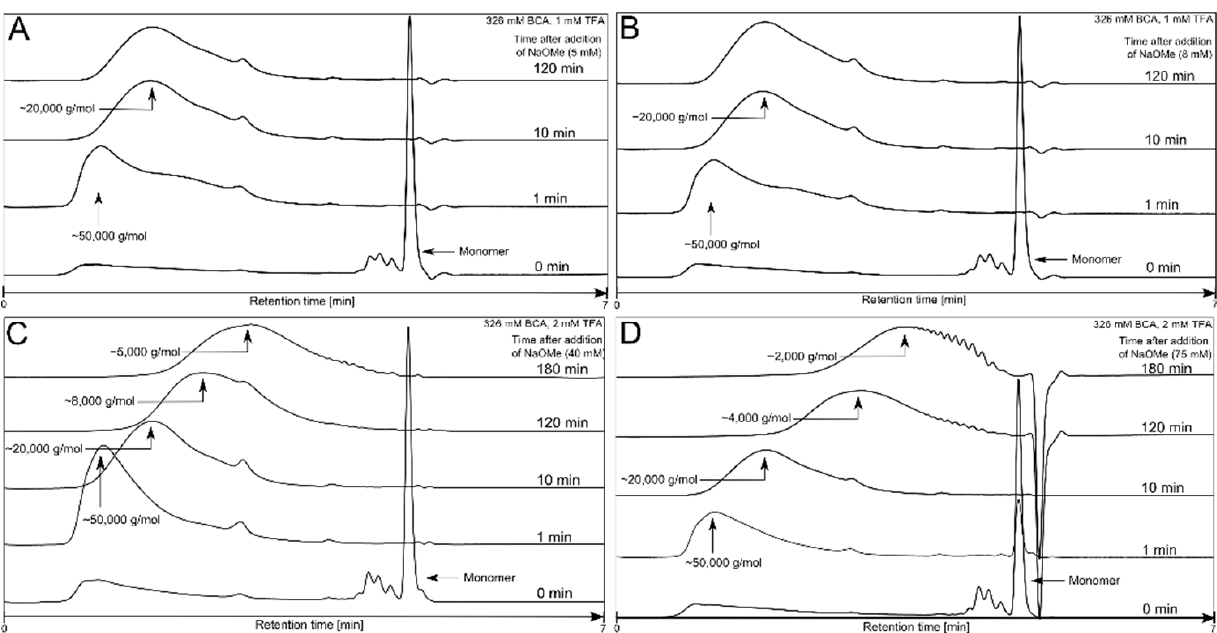
Figure 3. Initiation, propagation and depolymerization–repolymerization steps involved during anionic polymerization of BCA initiated by NaOMe in THF.